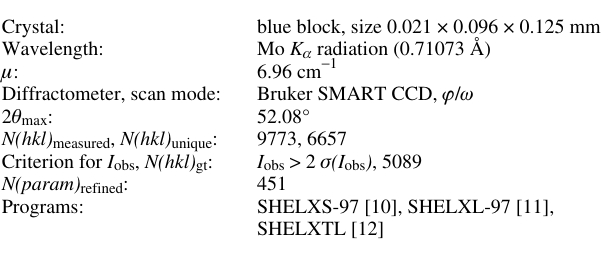
Table 1. Data collection and handling.